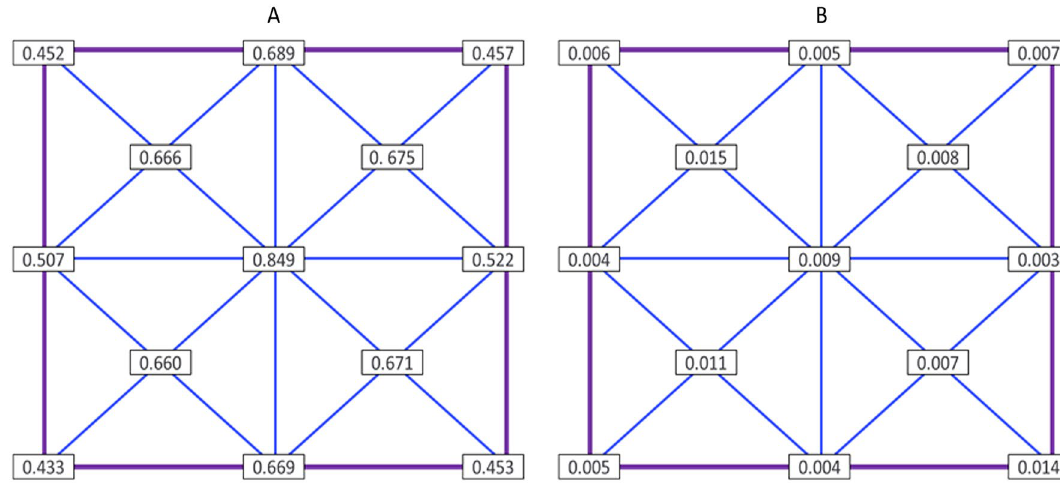
Figure 3. Average values of irradiance ( a ) and standard deviations ( b ) obtained from testing three lamps at given points within the UV-C device (mW/cm 2